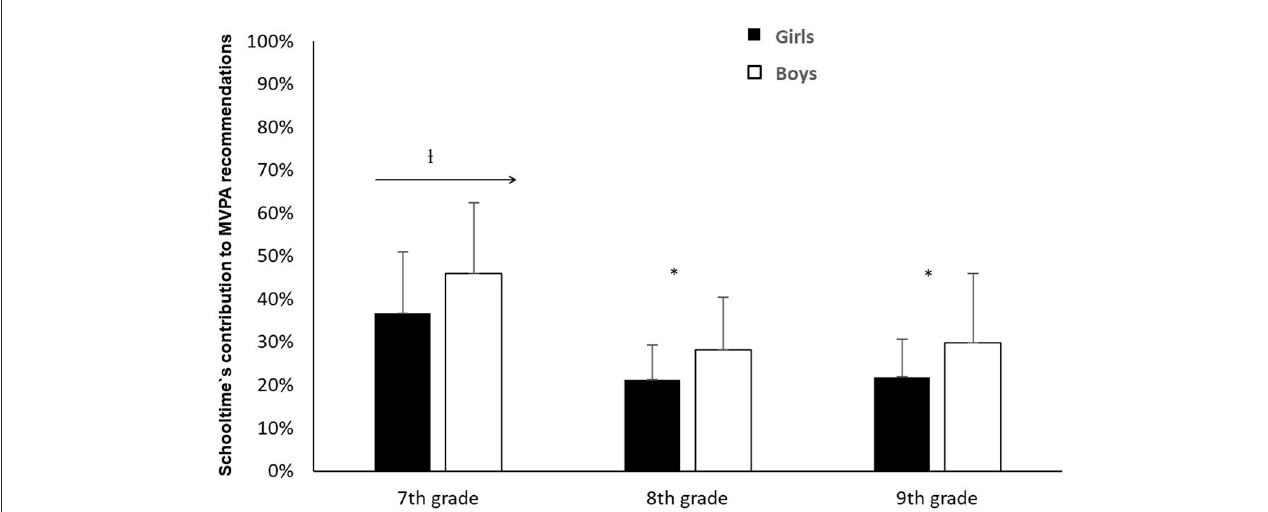
FIGURE3 Average percentage of schooltime’s weekly contribution of MVPA in relation to the health recommendation of 60min daily in MVPA for girls/boys + standard deviation. † Indicates a significant difference in schooltime’s contribution to pupils’ MVPA in relation to the health recommendation between 7 th grade and those to the right of the arrow between grade 7 and those to the right of the arrow ( p < 0.001). *Indicates a significant difference in schooltime’s contribution to the health recommendation between girls and boys ( p <